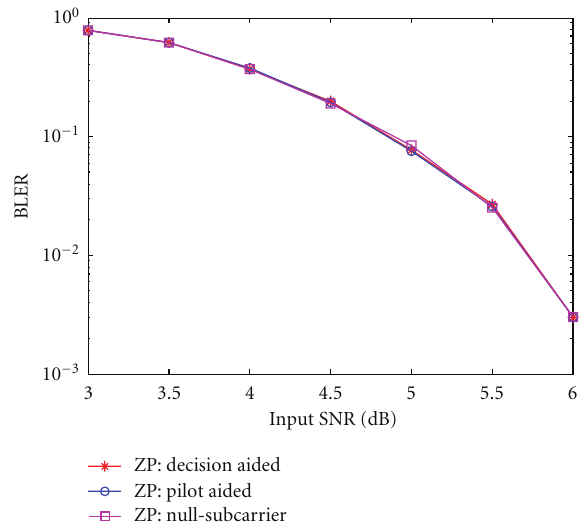
Figure 7: The BLER performance in multipath multi-Doppler channels (channel setting 3).